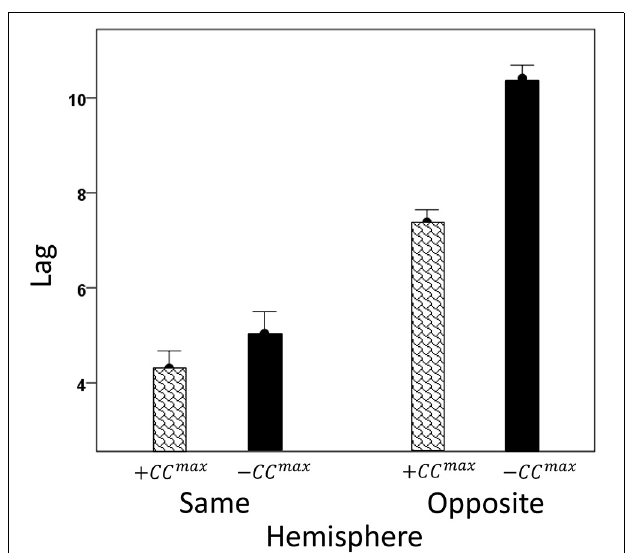
and predicting the time of a planned movement (Pesaran et